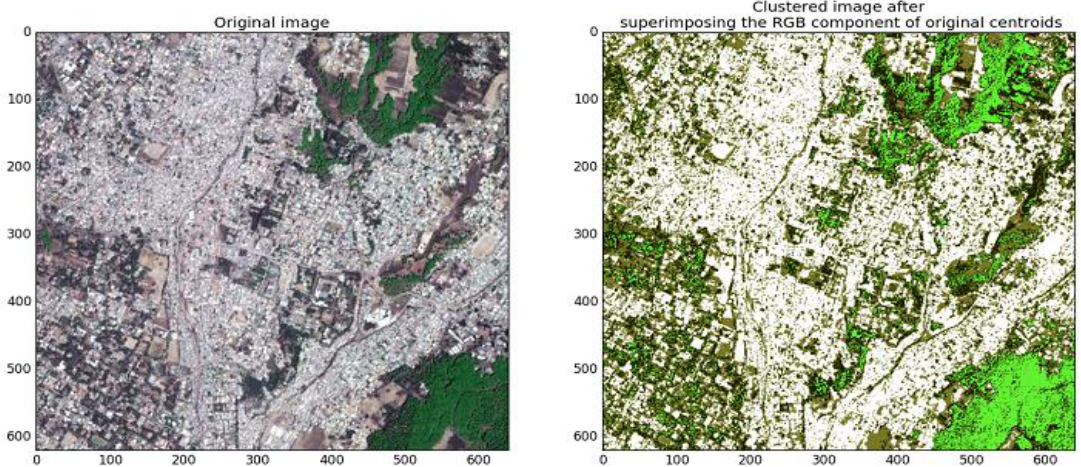
Figure. 5 . Comparison between the original image and the clustered image after superimposing the RGB component defined